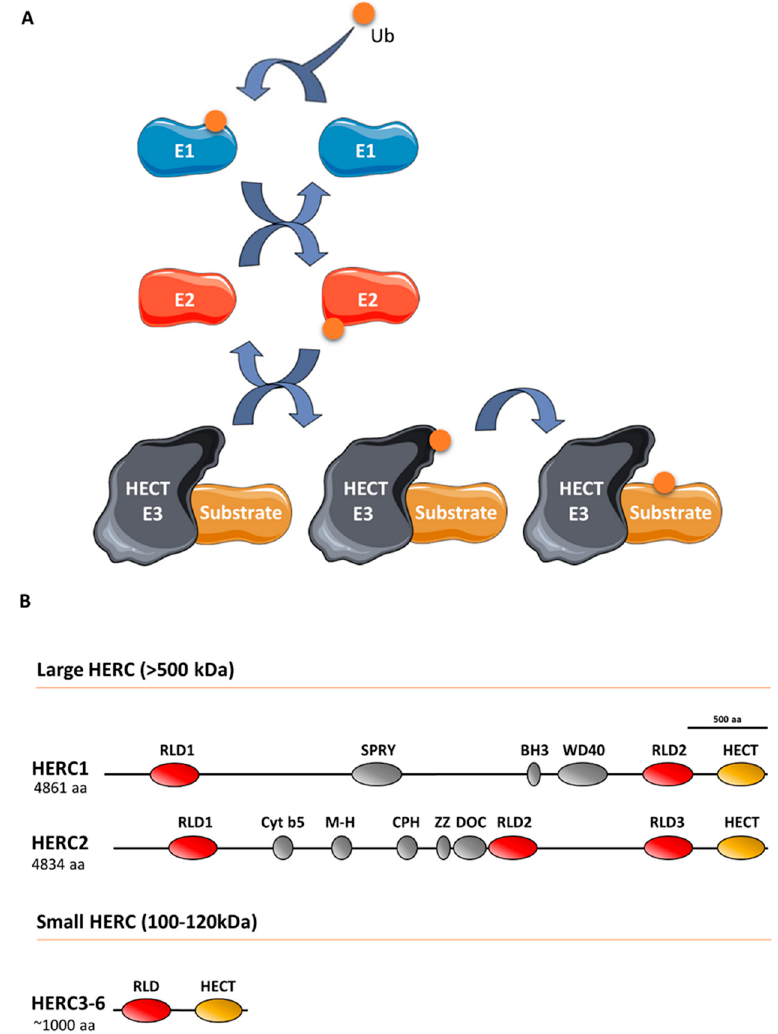
Figure 1. The ubiquitin-conjugating system in HERC E3 ligases: ( A ) Ubiquitin (Ub) is conjugated to a target substrate via a cascade that comprises an E1 activating enzyme, an E2 conjugating enzyme, and an E3 ligase enzyme. The HERC proteins belong to the HECT family of E3 ligases, which form a thioester bond with Ub via a conserved cysteine residue. Once formed, Ub is transferred to the substrate’s lysine residue (see text for details). Ub-like proteins, such as ISG15, are also covalently attached to the substrate protein via an E1 / E2 / E3 cascade; ( B ) structural features of large and small HERC proteins are also shown. HERC5 and HERC6 may also function as ISG15 E3 ligases.